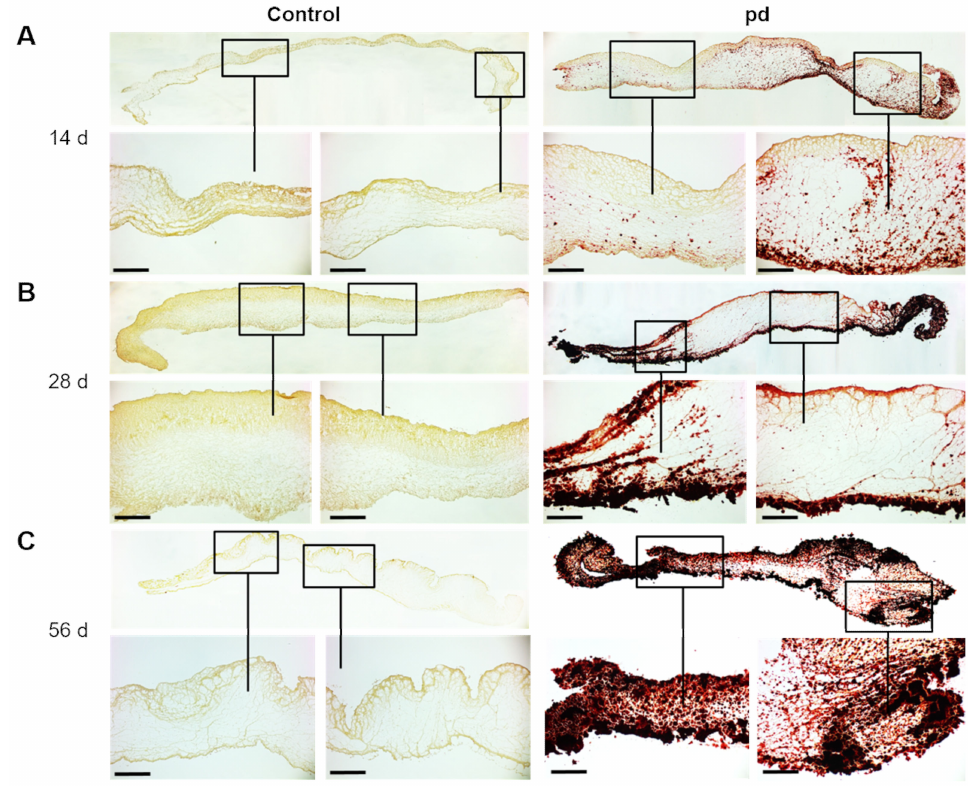
Figure 2. Temporal progression of AV leaflet degeneration. Alizarin red S staining of AV leaflets under pro-degenerative (pd) conditions ( β -GP + CaCl 2 ) after 14 d ( A ), 28 d ( B ), and 56 d ( C ) compared to control conditions. Red indicates sites of biomineralization. Scale bar indicates 100 µ m. Representative images of five different experiments are